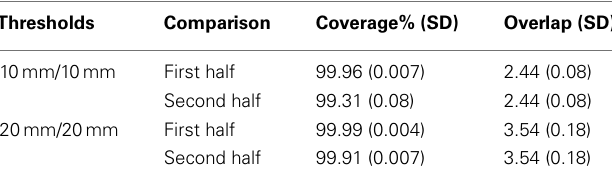
Table 2 | Performance of QB centroids tested on split halves of